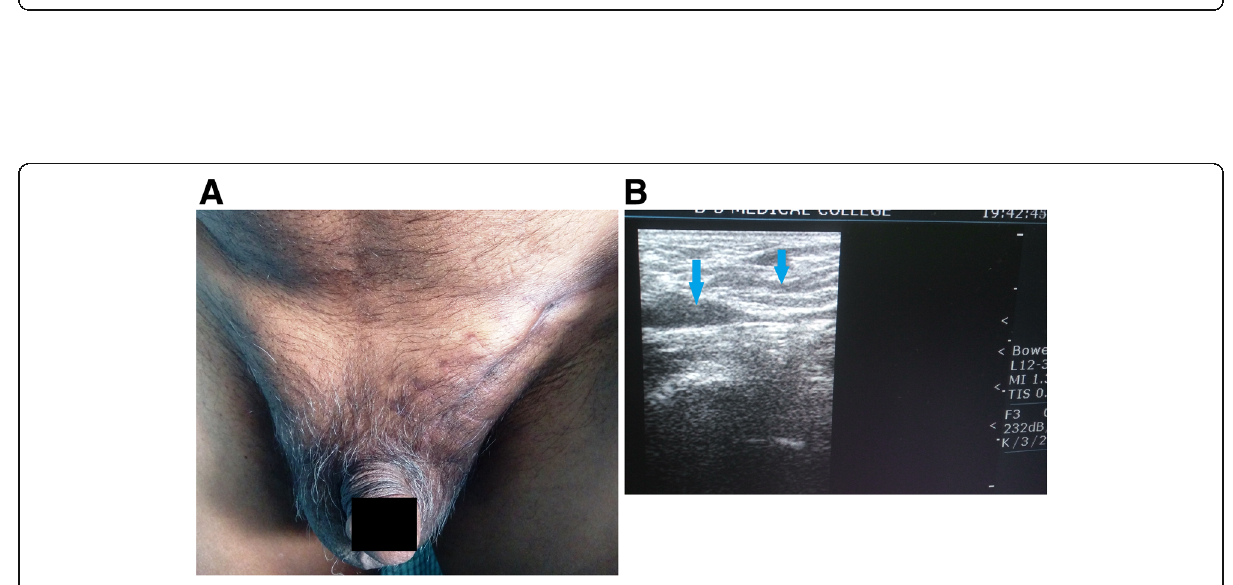
Fig. 3 a Grayscale ultrasonography demonstrate dilated, non-compressible, thrombosed tubular venous structure with increased wall thickness within the left spermatic cord. Within this tubular structure, focal echoes that belong to thrombus (green arrow) can be seen, but no vascular flow curve can be seen (red arrow). b On color Doppler ultrasound, no filling with the color was seen in the lumen of this vein within the left spermatic cord. On Doppler ultrasound, filling was seen within the neighboring arterial structure (green arrows), but not within the vein. c Computed tomography scan showing grossly distended and thrombosed spermatic veins (green arrows). d Sagittal section and e transverse section: fat- compressed axial T1 magnetic resonance images demonstrated thrombosed tubular venous structure (green arrows) with increased wall thickness and focal diameter increase within the bilateral spermatic cord. Within this venous structure, intraluminal signal intensity was